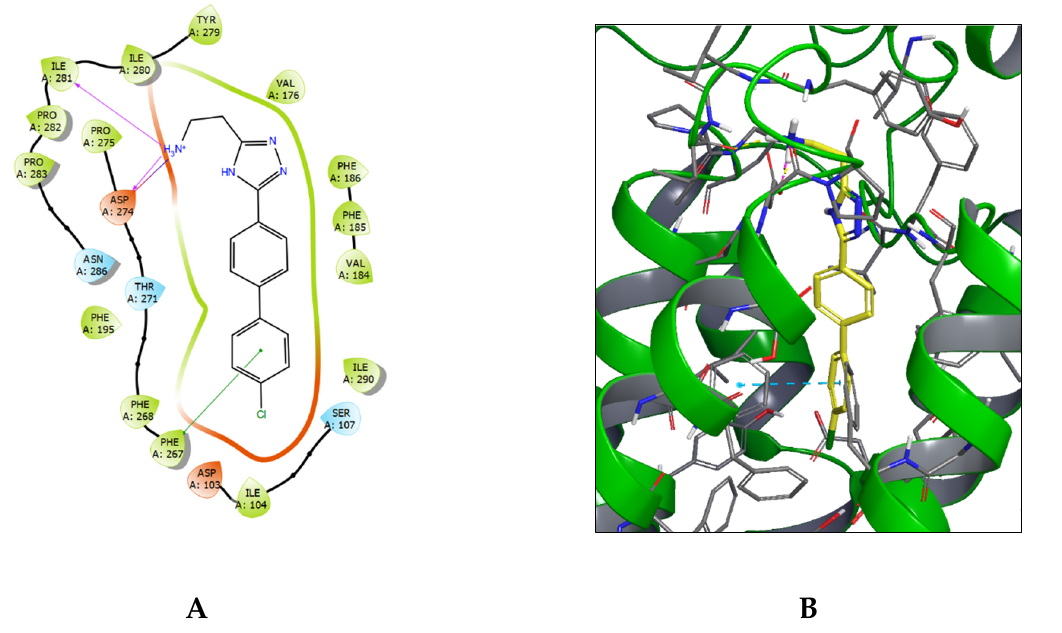
Figure 3. Ligand–protein complex of 62 (LK000764) with TAAR1; A —ligand interaction diagram, B —ligand positioning in TAAR1 protein structure (blue dashed line— π – π stacking interaction, yellow—hydrogen bond, magenta—salt bridge).